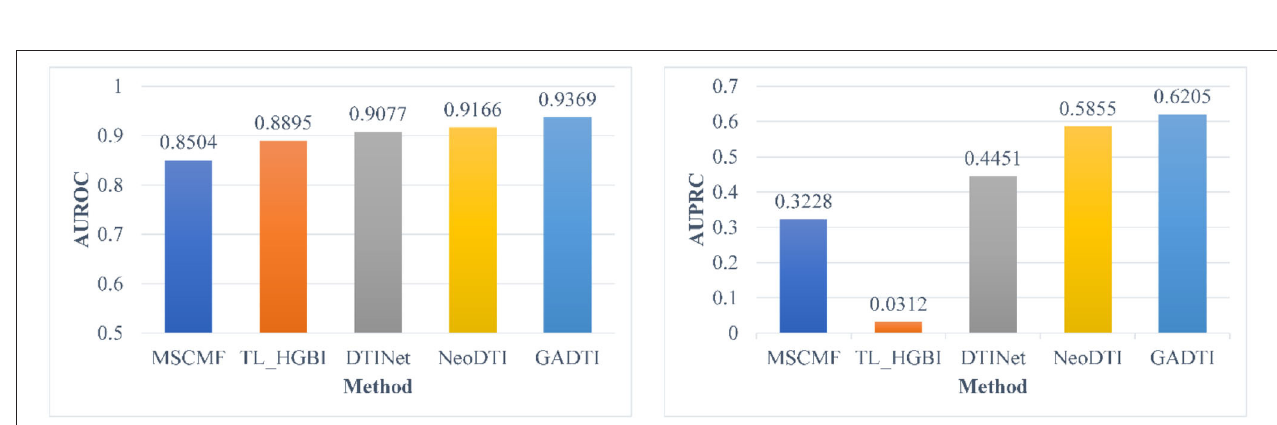
FIGURE 6 | Comparison between different methods in terms of AUROC and AUPRC based on 10-fold cross-validation (all unknown pairs were treated as negative examples).